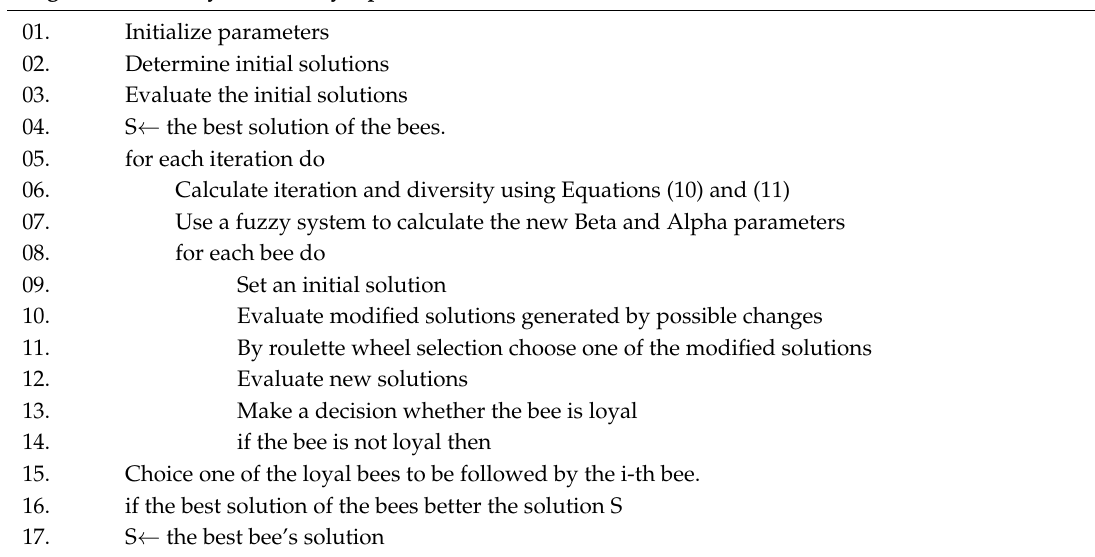
Algorithm 2. Fuzzy Bee Colony